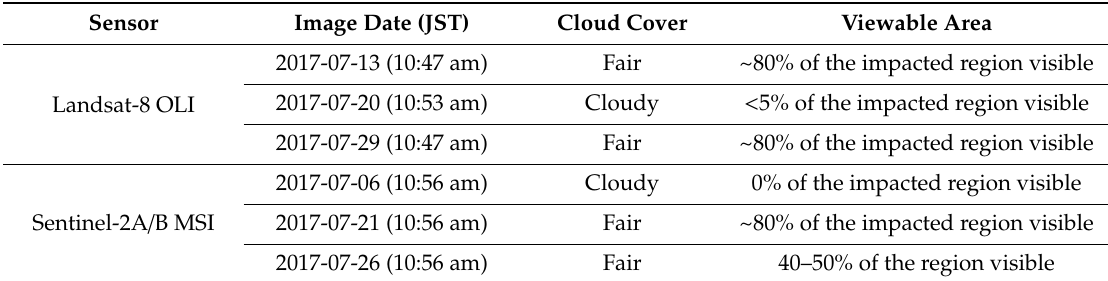
Table 3. Landsat-8 OLI and Sentinel-2A / B MSI Images Acquired during 5 July 2017 to 31 July 2017 and Their Cloud Cover Condition